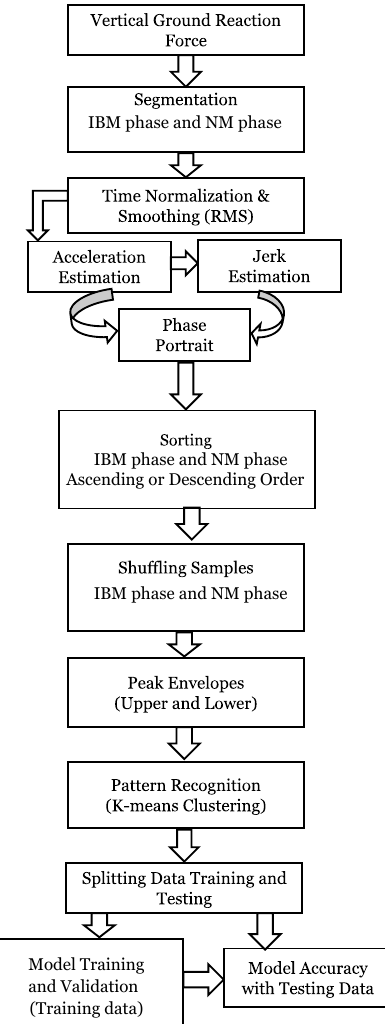
Figure 1. The framework for the clustering and classification of IBM